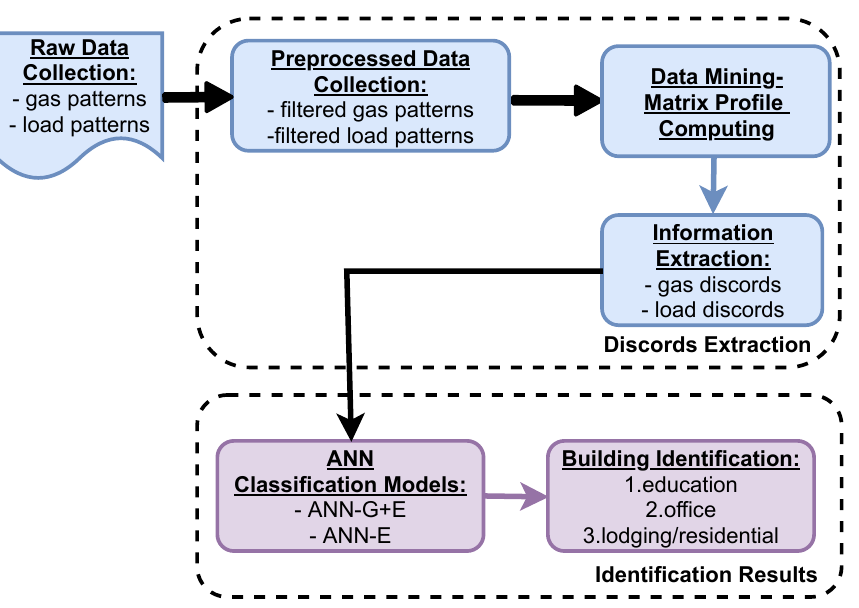
Figure 1. The two-dimensional building identification